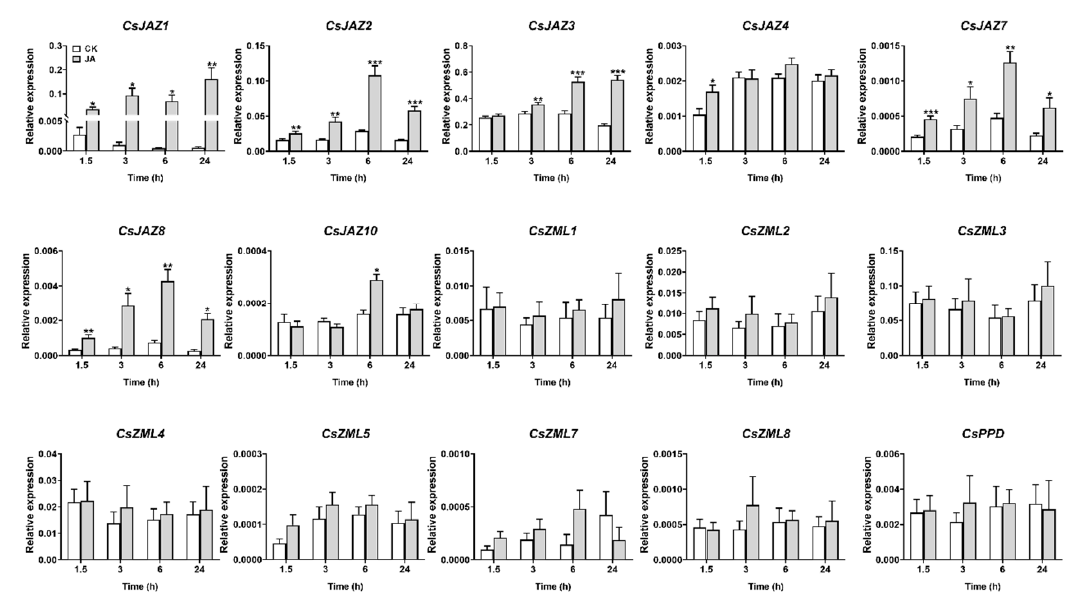
Figure 5. Expression profile of CsTIFY genes elicited by exegenous application of jasmonate acid (JA). Data are shown by the mean + SE, asterisks indicate a significant difference between treatment and control (Student’s t -test, * p < 0.05, ** p < 0.01, *** p < 0.001, n = 6).